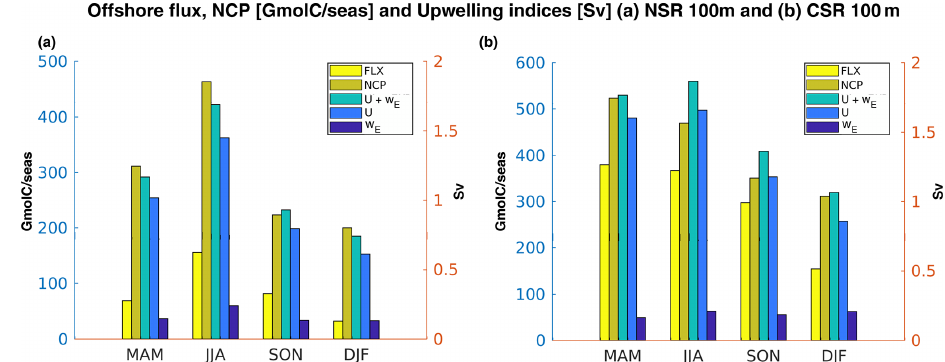
Figure 10. C org offshore Fluxes (FLX), NCP fluxes (NCP), upwelling transport ( U + w E ), coastal upwelling ( U ), and Ekman pumping ( w E ) in (a) northern and (b) central CanUS by season. Fluxes are integrated along the coast and in the first 100m and they represent the flux through the 100km offshore boundary. U is integrated along the coast and w E is integrated along the latitude and in the 100km offshore (see Sect. 2.3 for upwelling estimations definition). Each group of bars represents a different season.